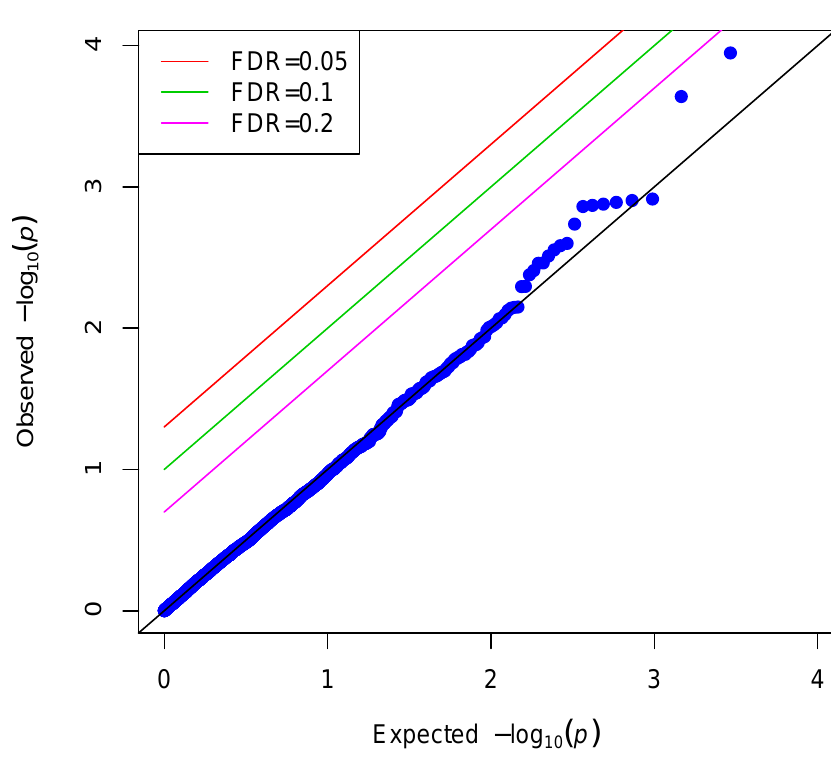
Figure 1. Q–Q plot for the unweighted